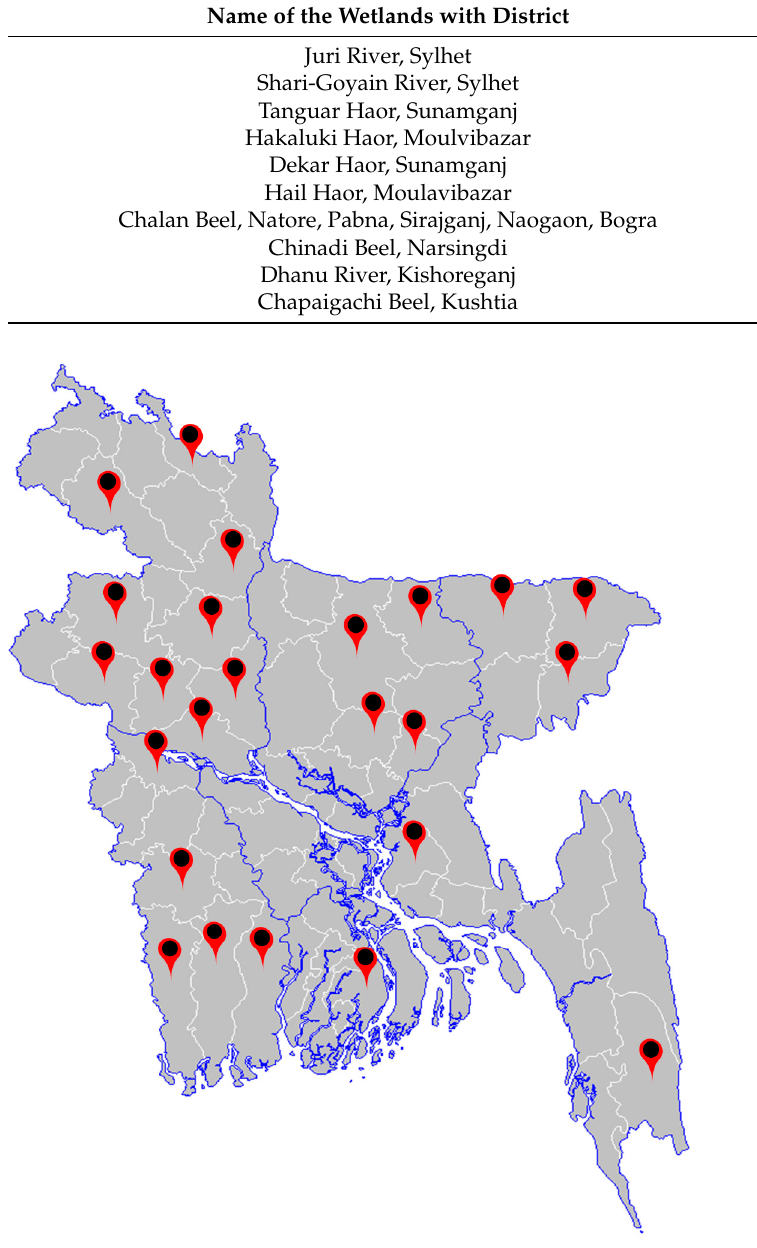
Figure 3. District-wise distribution of Bagarius bagarius in Bangladesh.